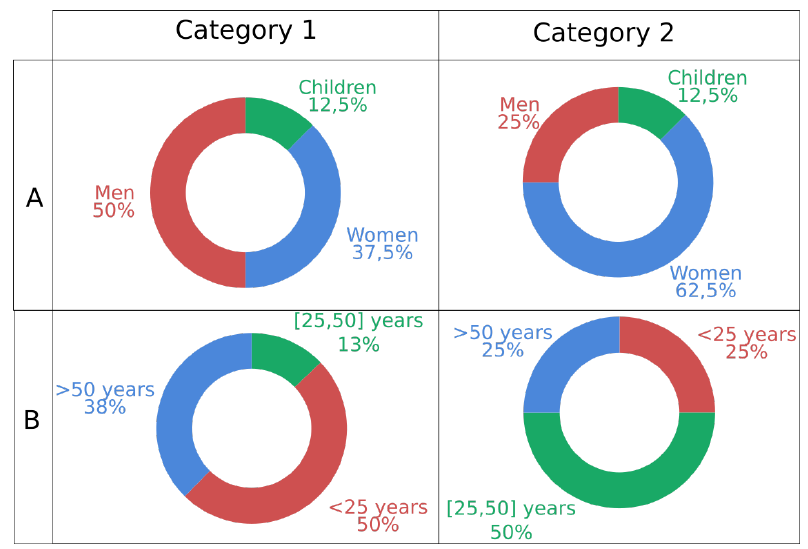
Figure 10. Speakers categories ( A ) Gender distribution. ( B ) Age